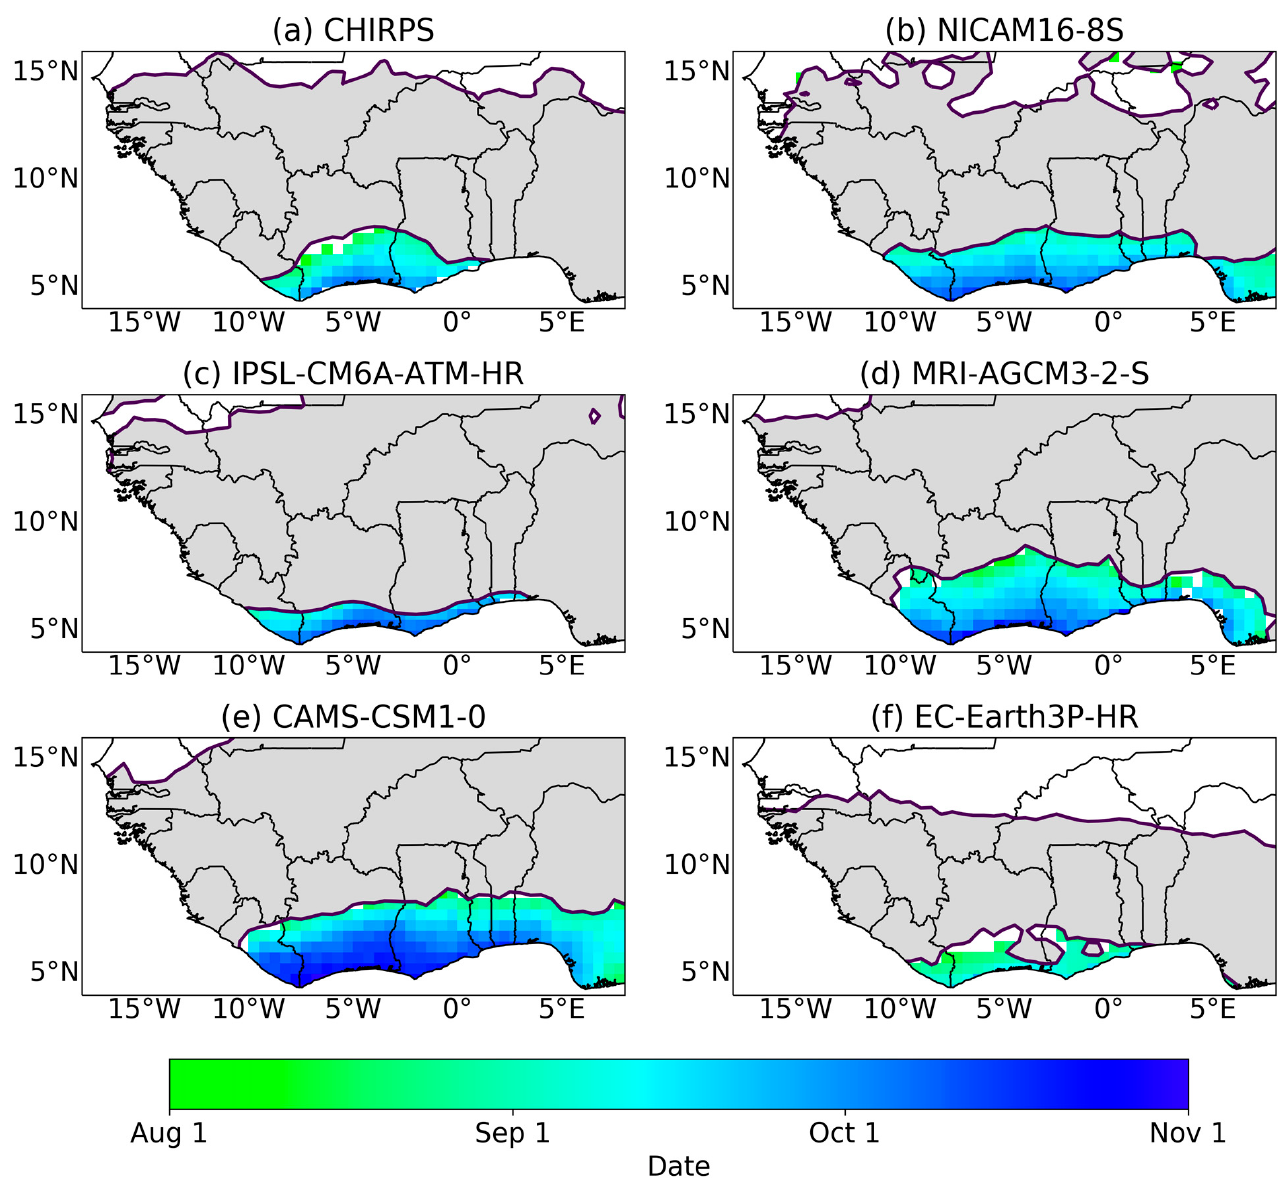
Figure 7. Mean onset date for second (minor) rains for all data sets. Dark grey indicates annual regimes and white indicates dry regions.